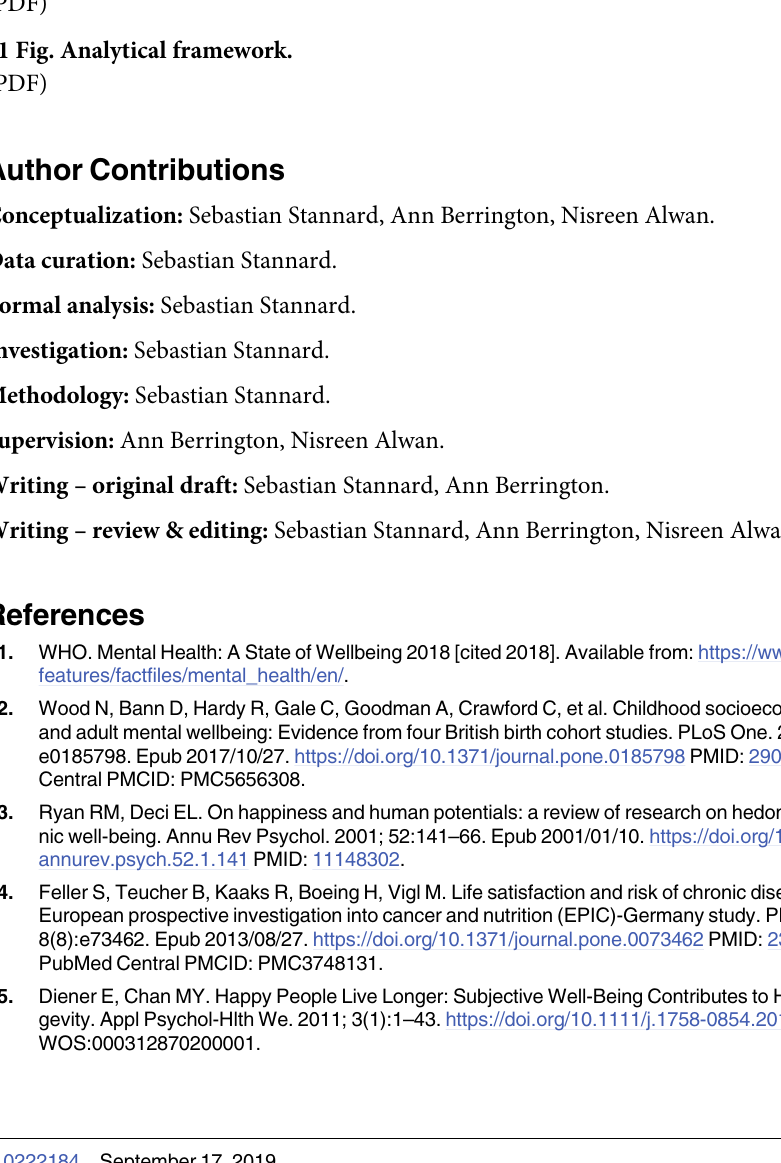
S1 Table. Loss to follow up: Sample characteristics at birth for all respondents at birth and respondents followed up at age 42. S2 Table. Loss to follow up: Sample characteristics at 10 for respondents at age 10 and respondents followed up at age